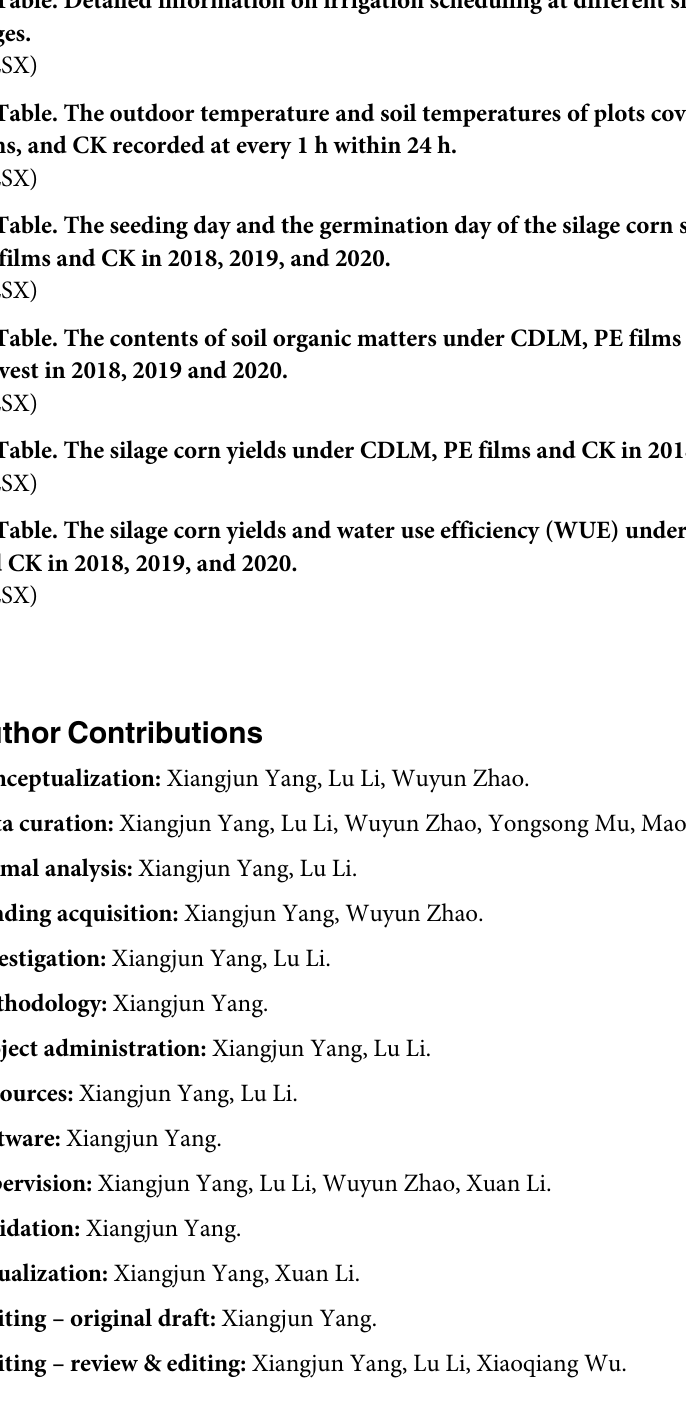
S1 Table. The precipitations and the max and min daily temperatures of the experimental sites (2018–2020). S2 Table. Detailed information on irrigation scheduling at different silage corn growth stages. S3 Table. The outdoor temperature and soil temperatures of plots covered by CDLM, PE films, and CK recorded at every 1 h within 24 h. S4 Table. The seeding day and the germination day of the silage corn seeds under CDLM, PE films and CK in 2018, 2019, and 2020. S5 Table. The contents of soil organic matters under CDLM, PE films and CK after the